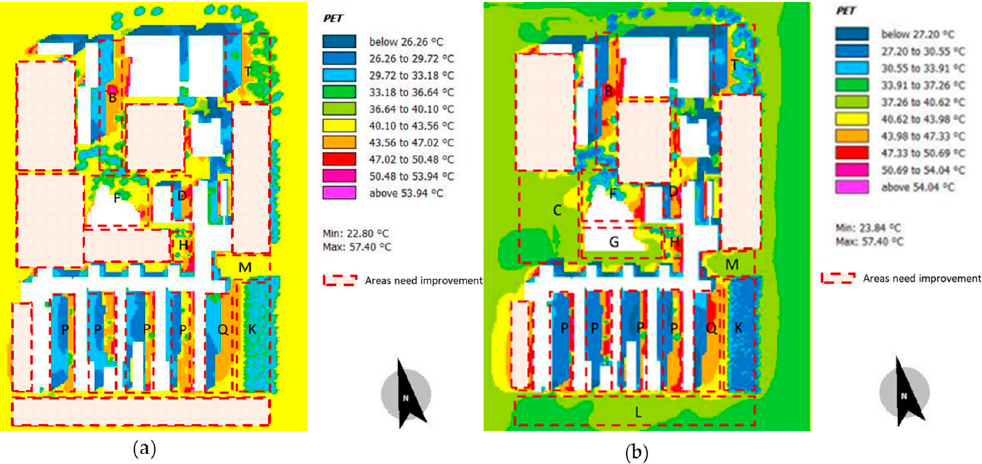
Figure 14. Visual results of PET and areas with PET values higher than need improvement, sample p4m2c1, date 4 June, based on the microclimatic data of the campus ( a ), sample p1m1c1, date 7 June, based on the microclimatic data of the campus ( b ).